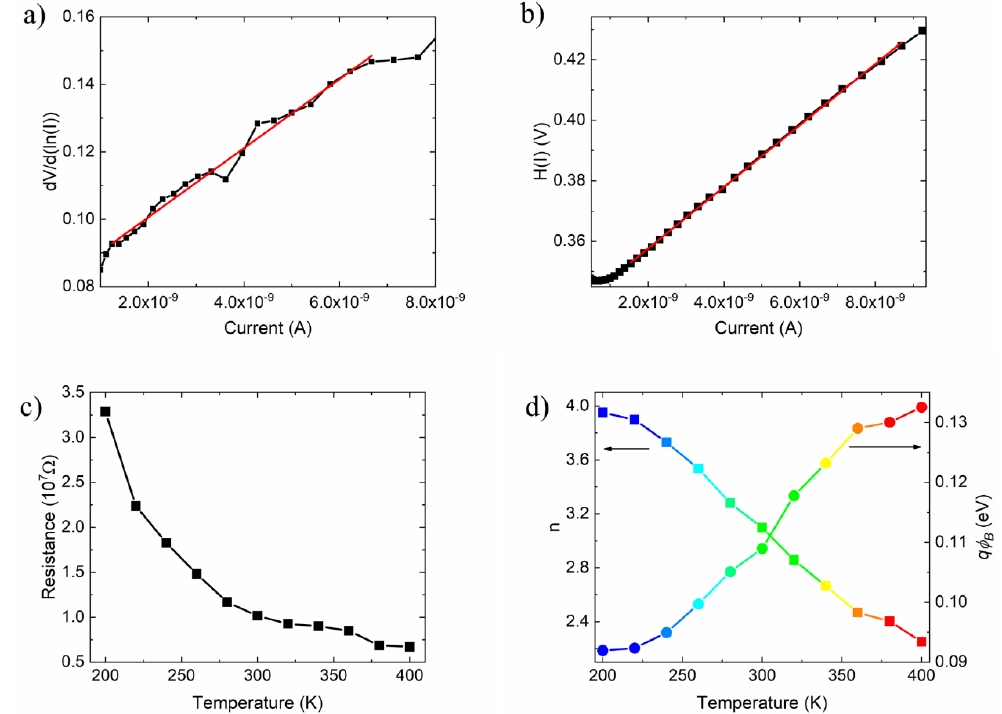
Figure 3. Cheung’s plot of ( a ) dV / d ln ( I ) vs I and ( b ) H ( I ) vs I at 300 K . ( c ) Devices series resistance, ( d ) ideality factor and the Schottky barrier extracted from the Cheung and Cheung (CC) method versus the temperature.